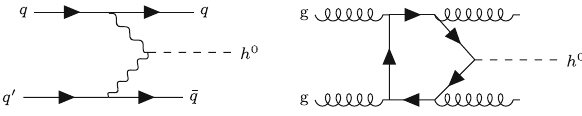
2 Vector boson fusion production of Higgs and analysis